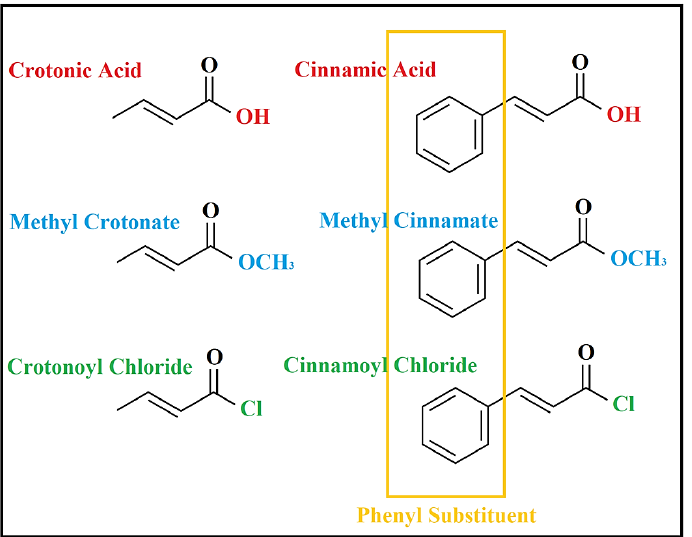
Figure 1. Molecular structures of the studied compounds in the SEI formation process.